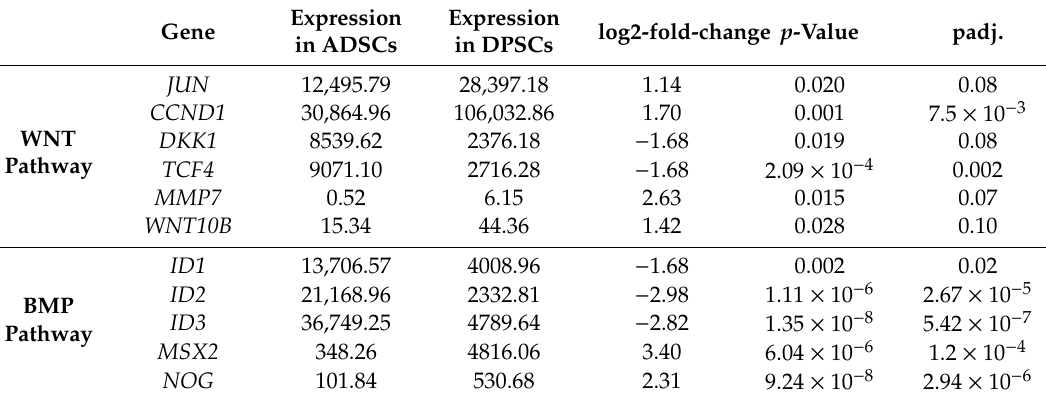
Table 2. DEGs involved in